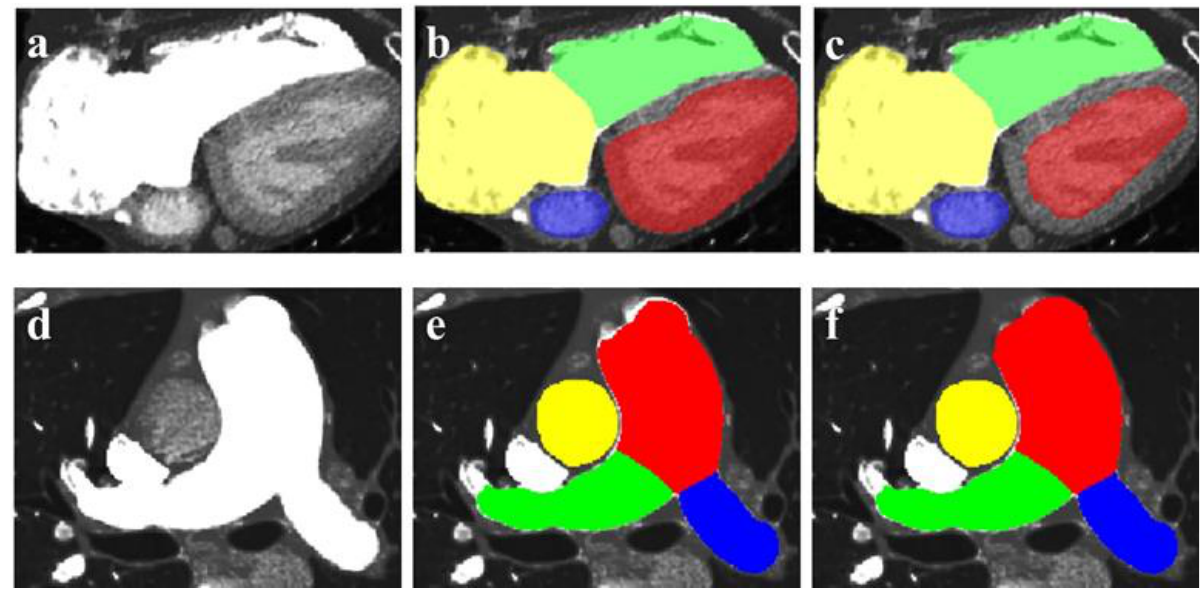
Figure 4. The performance of the proposed network framework. ( a , d ) are the original image of heart and pulmonary artery, respectively; ( b , e ) are the segmentation outputs of nnU-Net; ( c , f ) are the segmentation outputs of the proposed network framework.